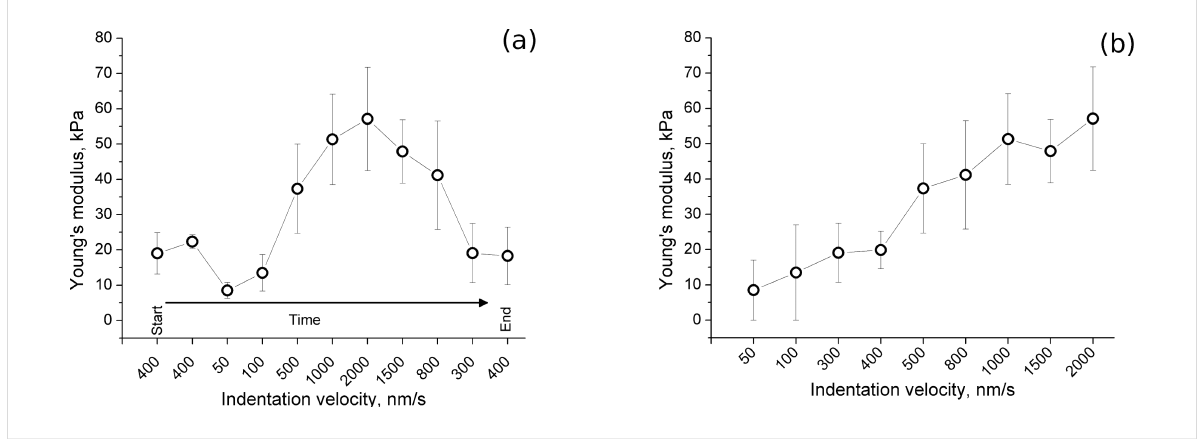
Figure 6: Calculated Young’s modulus E for (PLL/HA) 72 with different indentation velocities sorted by (a) the measurement order (b) indentation velocity. Error bars show the standard deviation from 15 measurements.